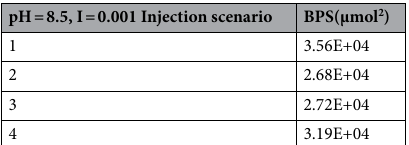
Table 6. Calculated BPS using the developed model.